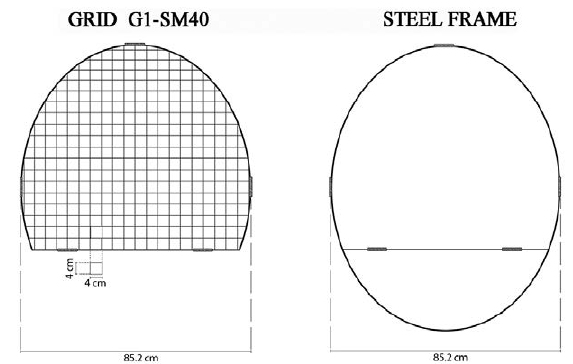
Fig. 2. – Designed sorting grid used in the present study: